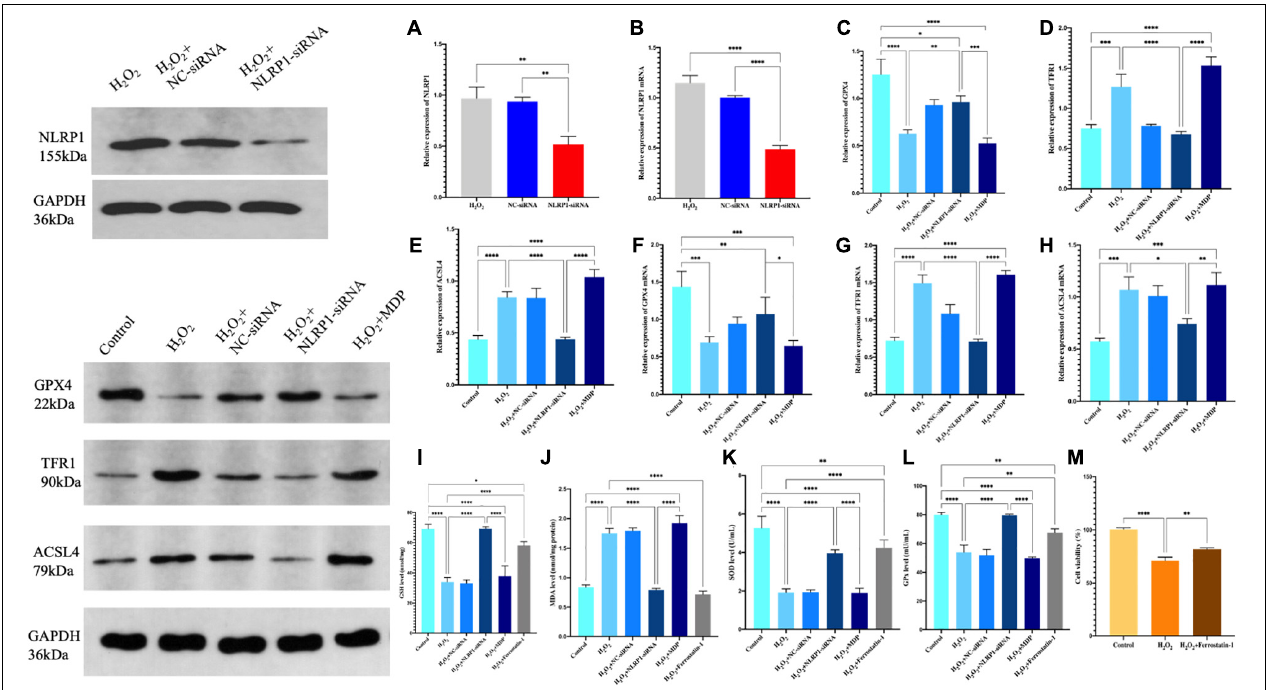
FIGURE 2 | The expression levels of the NLRP1 in HTR-8/SVneo cells transfected with siRNA-NLRP1 were detected by western blot (A) and qRT-PCR (B) . The expression levels of NLRP1 at the mRNA levels were significantly down-regulated after siRNA-NLRP1 (** P < 0.01), as compared with the H 2 O 2 and siRNA-NC groups. (C–E) Ferroptosis-related protein expression in HTR-8/SVneo cells were detected by western blot. (C) GPX4, (D) TFR1, and (E) ACSL4 (** P < 0.01). (F–H) mRNA expression in HTR-8/SVneo cells was detected by qRT-PCR. (F) GPX4, (G) TFR1, and (H) ACSL4 (* P < 0.05 and ** P < 0.01). (I–K) Ferroptosis levels in the HTR-8/SVneo cell model of oxidative stress l. (I) GSH, (J) MDA, (K) SOD, and (L) GPx. (M) CCK-8 assay was used to detect cell activity (* P < 0.05, ** P < 0.01, *** P < 0.001, and **** P < 0.0001). Values represent means ± SD, n = 3 per